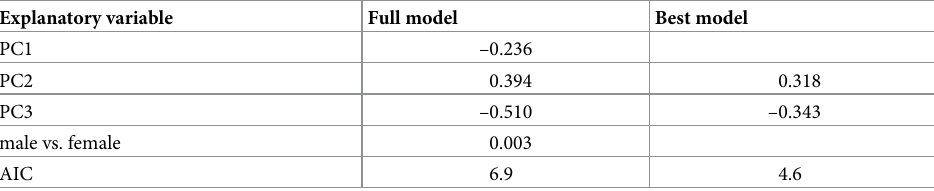
Table 4. Standard partial regression coefficient for LMA and AIC based on the